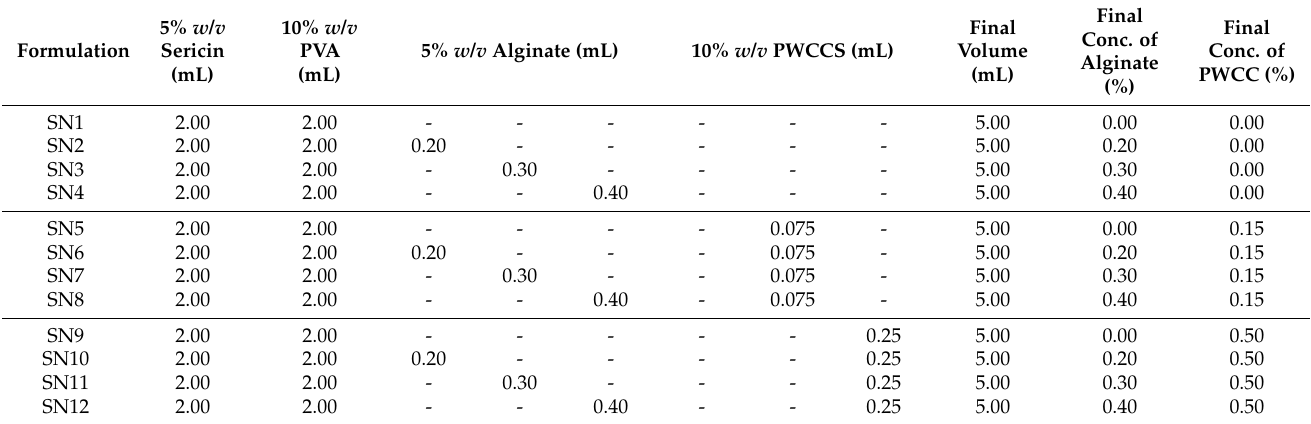
Table 1. The composition of the hydrogel